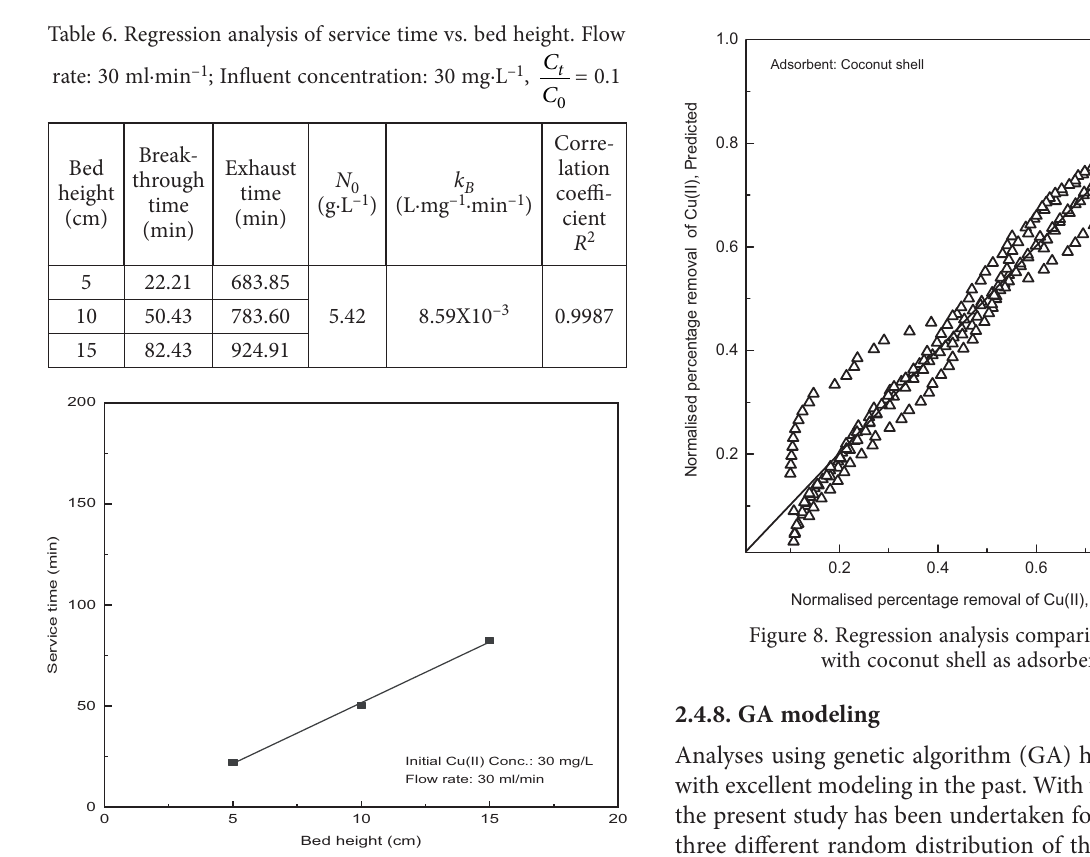
Figure 7. BDST model